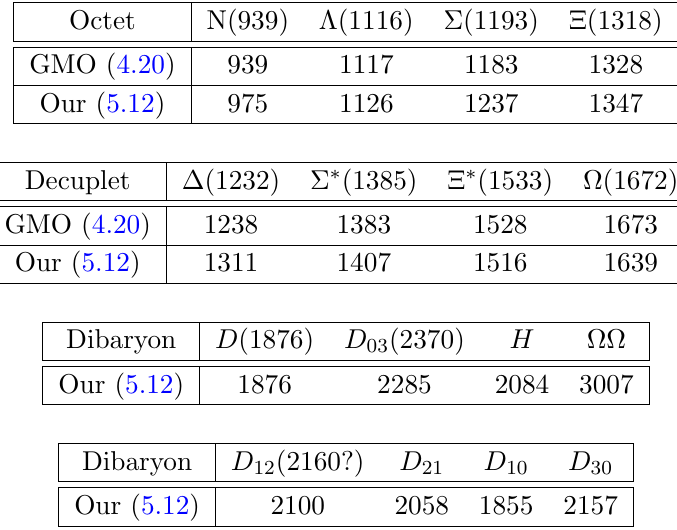
Table 4 . A numerical (cid:12)t of the hyperon and dibaryon spectrum by our formula (5.12). strange quarks and the corresponding state in our model is given by (cid:16) (cid:17) (cid:16) j i = (cid:15) (cid:15) _ (cid:11) 1 _ (cid:11) 2 (cid:11) y a 1 (cid:11) y a 2 (cid:15) (cid:15) _ (cid:11) 3 _ (cid:11) 4 (cid:11) y a 3 (cid:11) y a 4 a 1 a 2 a 3 a 4 _ (cid:11) 1 i =3 _ (cid:11) 2 i =3 _ (cid:11) 3 i =3 _ (cid:11) 4 i =3